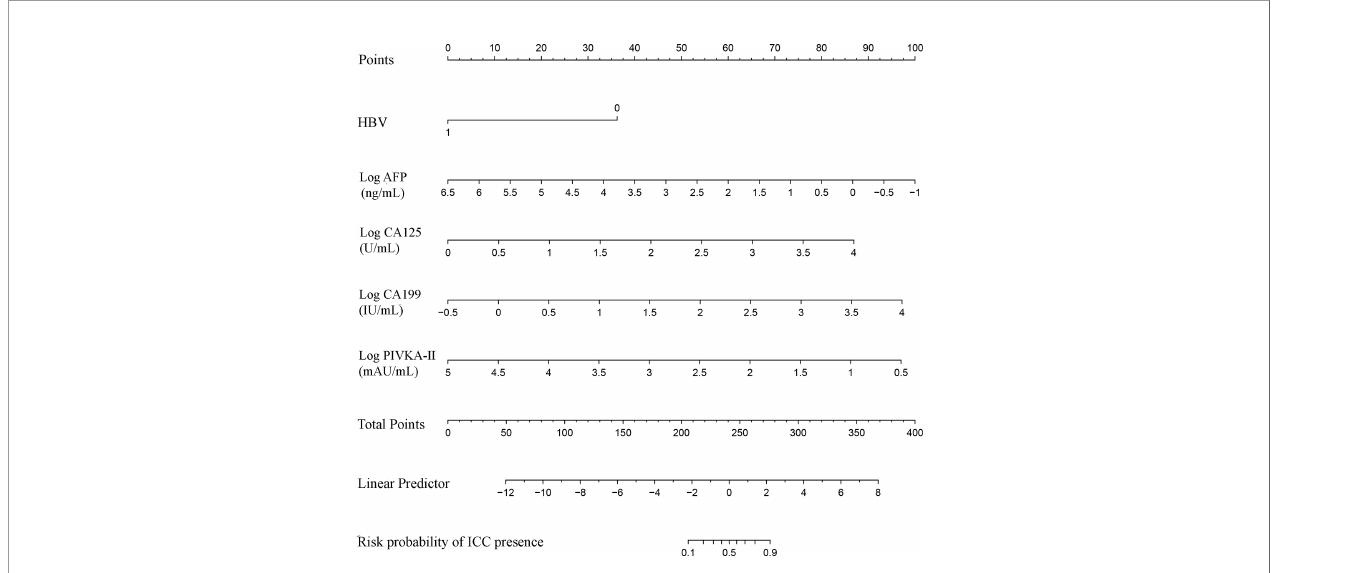
FIGURE 2 | The nomogram discriminates ICC from HCC. To use the nomogram, fi nd the position of each variable on the corresponding axis, then draw a line to the points axis at the top of the nomogram to calculate the respective points for each parameter; fi nally, add the total points from all parameters and draw a line from the total points axis to the risk probability axis at the bottom of the nomogram to determine ICC presence